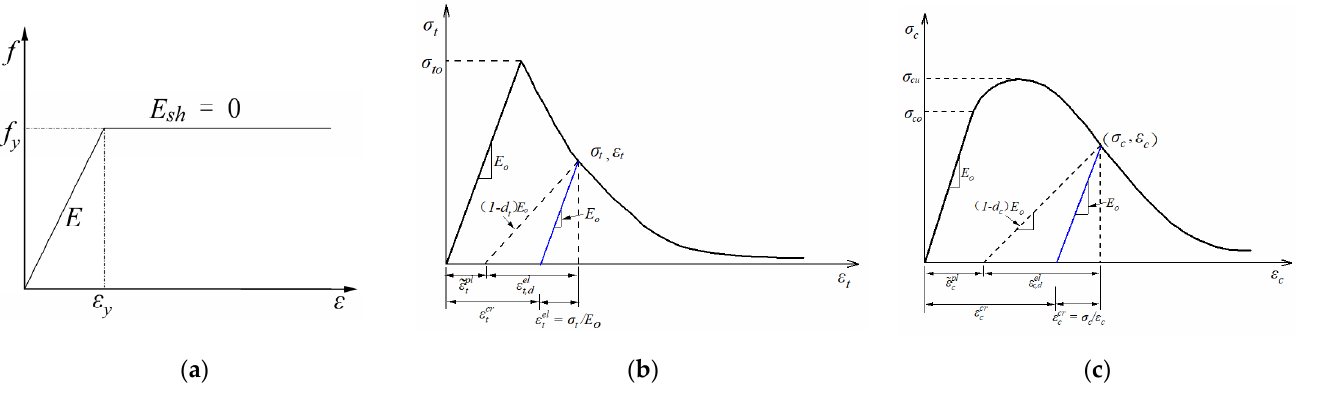
Figure 3. Stress–strain relationships of various materials: ( a ) stiffened steel tube; ( b ) concrete under uniaxial loading in tension; and ( c ) concrete under uniaxial loading in compression. Table 2. Material parameters of the composite lining.